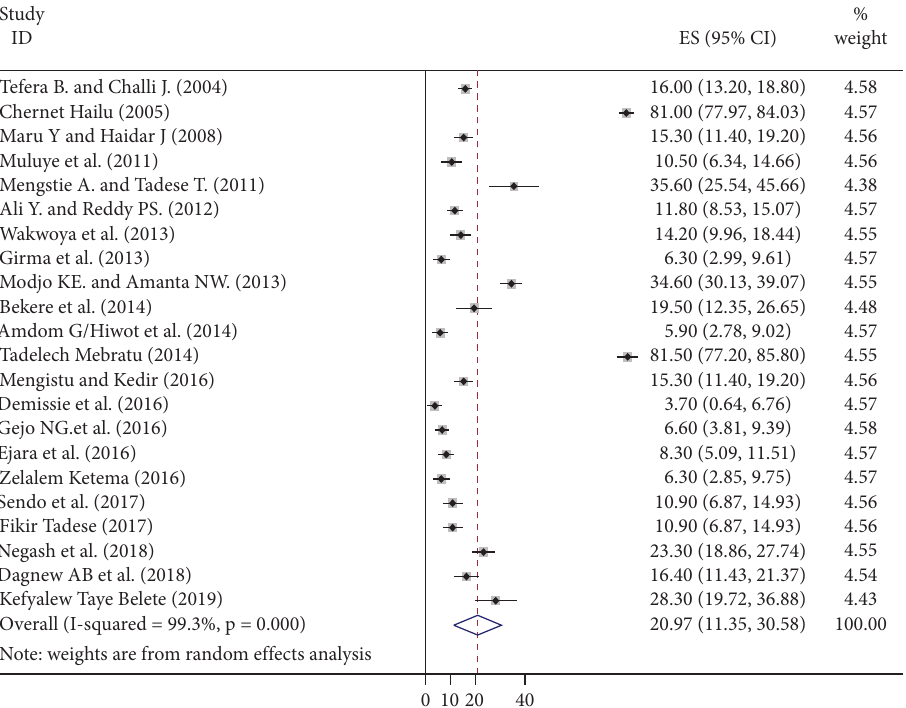
Figure 4: Forest plot showing the pooled prevalence of mixed feeding practice of HIV-exposed infants in Ethiopia.